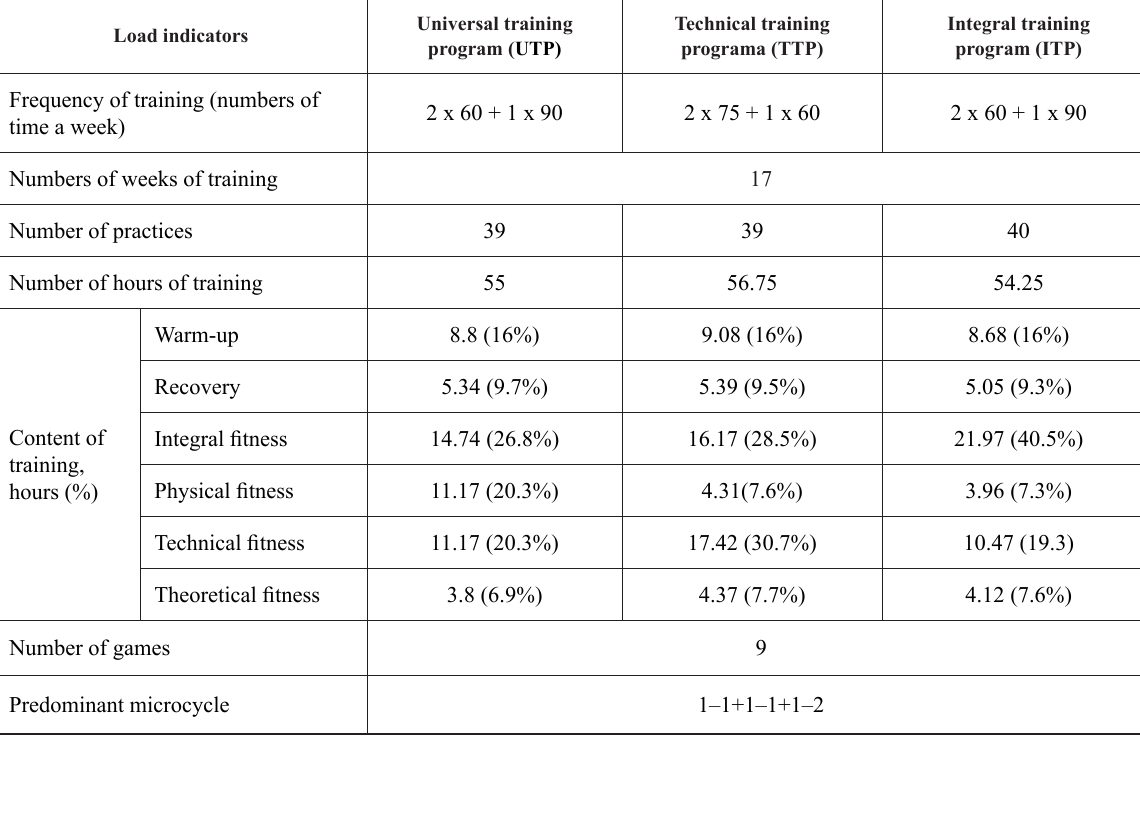
Figure 1. Distribution of